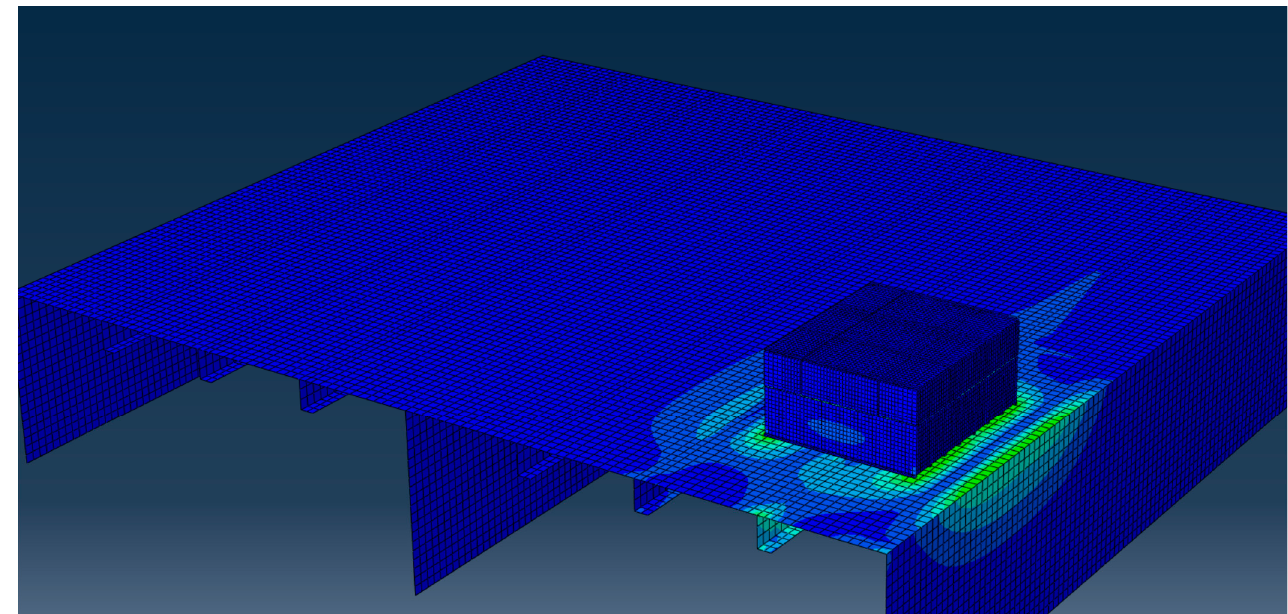
Figure 17. Stress concentration through hull deflection in Model 3.